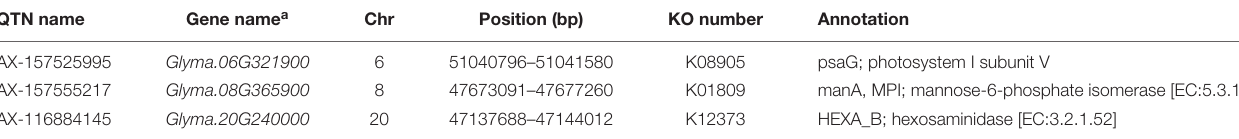
TABLE 6 | Details of three candidate genes annotated in the KEGG